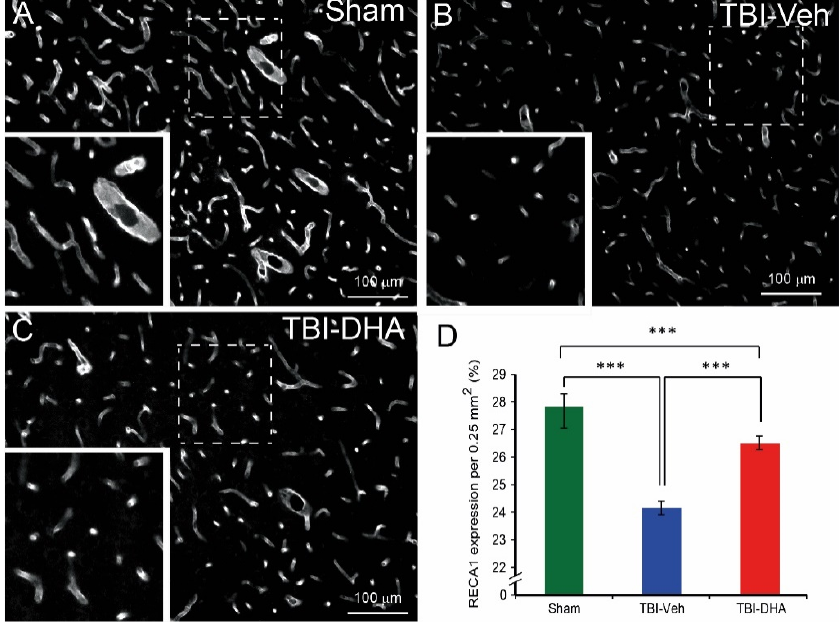
Figure 4. DHA-treated TBI rats exhibited more anti-rat endothelial cell antigen-1 (RECA-1) expression at the peri-injury site than the vehicle-treated TBI rats at 7 days post injury. ( A ) In sham-operated rats, lots of visible RECA-1 expression was observed along the large and small caliber blood vessels. ( B ) Vehicle-treated TBI rats exhibited some RECA-1 expression in small calibre blood vessels. ( C ) DHA-treated TBI rats exhibited some RECA-1 expression in both large and small caliber blood vessels. ( D ) Analysis of RECA-1 expression at the pericontusional site revealed a significantly reduced loss of RECA1 expression in blood vessels in DHA-treated rats (red, n = 6) compared vehicle-treated TBI rats (blue, n = 6) at 7 days post injury. RECA1 expression in sham-operated rats (green, n = 4) was significantly higher than TBI rats. The *** indicates p < 0.001.